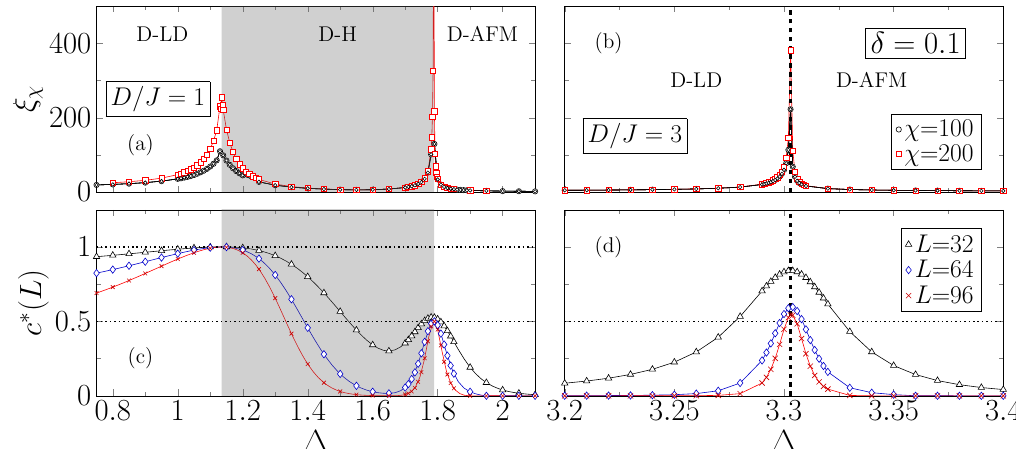
Figure 6: Correlation length ξ χ (upper panels) and central charge c ∗ ( L ) (lower pan- els) for fixed D / J = 1 (left panels) and 3 (right panels) with δ =